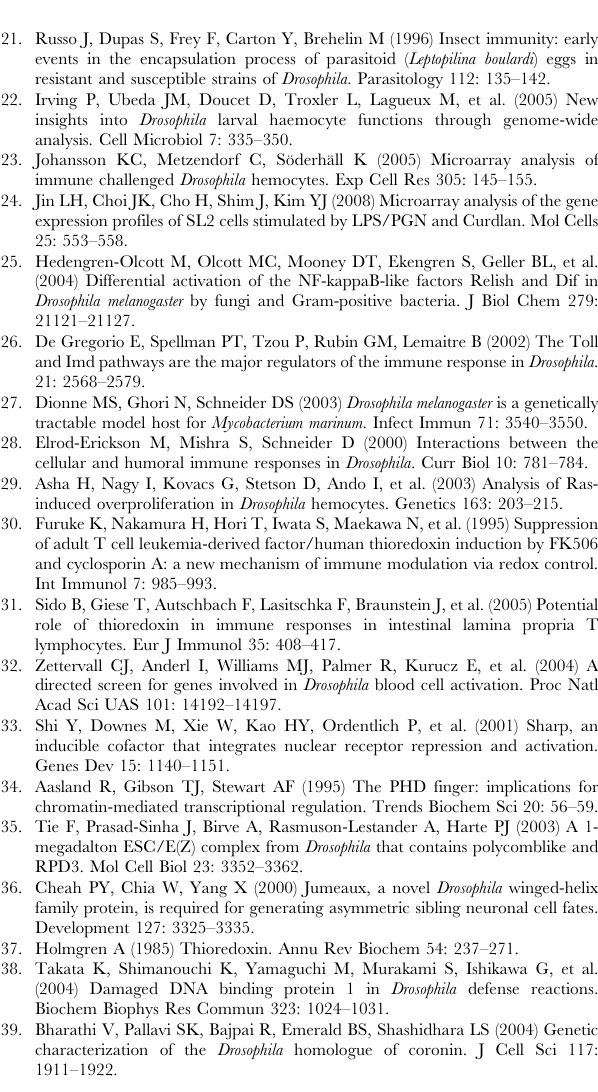
Table S2 GenExel EP lines isolated from the antifungal screen. Found at: doi:10.1371/journal.ppat.1000168.s002 (0.05 MB Table S3 Primer sequences used for PCR analyses. Found at: doi:10.1371/journal.ppat.1000168.s003 (0.06 MB